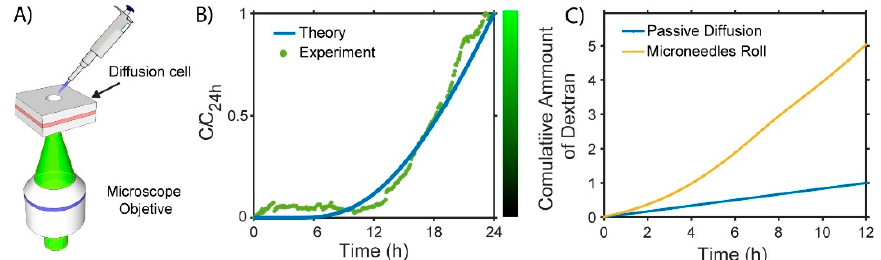
Figure 3. ( A ) Schematic (not in scale) of the experimental setup used for the real-time diffusion experiments. ( B ) Experimental and theoretical normalized FITC-dextran concentration vs. time. C 24h denotes the concentration detected at the focal plane of the objective after 24 h. ( C ) Assessment of a microneedle roller as TDD. Cumulative amount vs. time curve of FITC-dextran diffused through the untreated mice skin and the microneedle-treated mice skin. To better highlight the enhancement in diffusivity due to the microneedles’ action, both curves were normalized with respect to the cumulative amount of FITC-dextran diffused through the untreated skin after 12